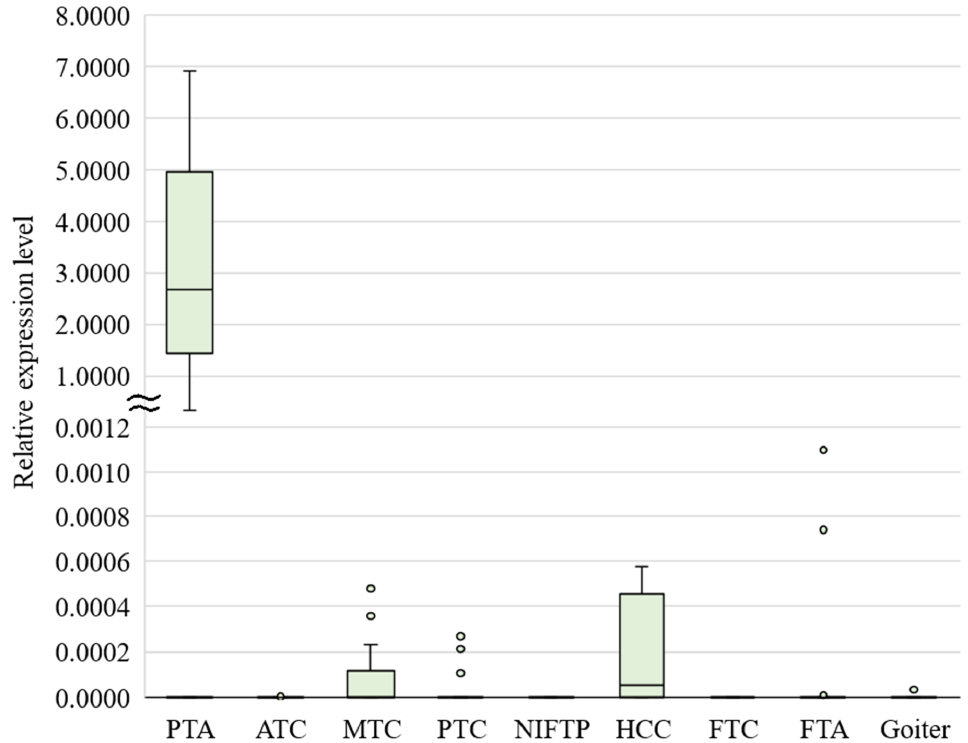
Figure 1. GCM2 mRNA expression in parathyroid and thyroid tumors and goiters, presenting the median value, upper and lower quartiles, a nonoutlier range, and outliers (circles). PTA, parathyroid adenoma; ATC, anaplastic thyroid carcinoma; MTC, medullary thyroid carcinoma; PTC, papillary thyroid carcinoma; NIFTP, noninvasive follicular thyroid neoplasm with papillary-like nuclear features; HCC, Hürthle cell carcinoma; FTC, follicular thyroid carcinoma; FTA, follicular thyroid adenoma.